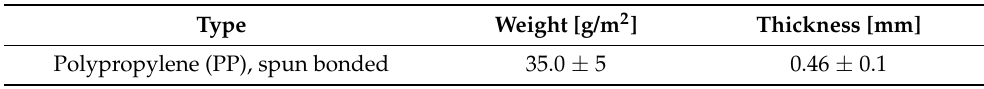
Table 1. Characteristic of non-woven